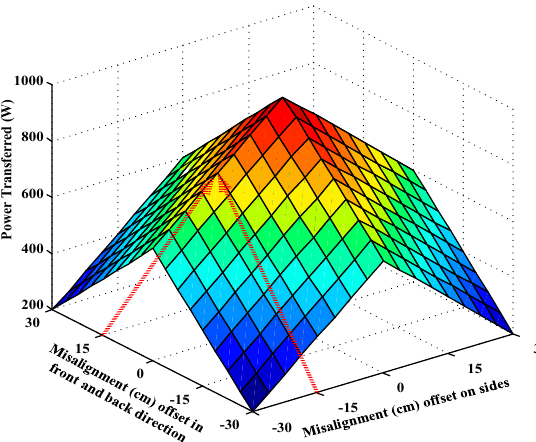
Figure 8. Power transferred during misalignment in across side and longitudinal direction.